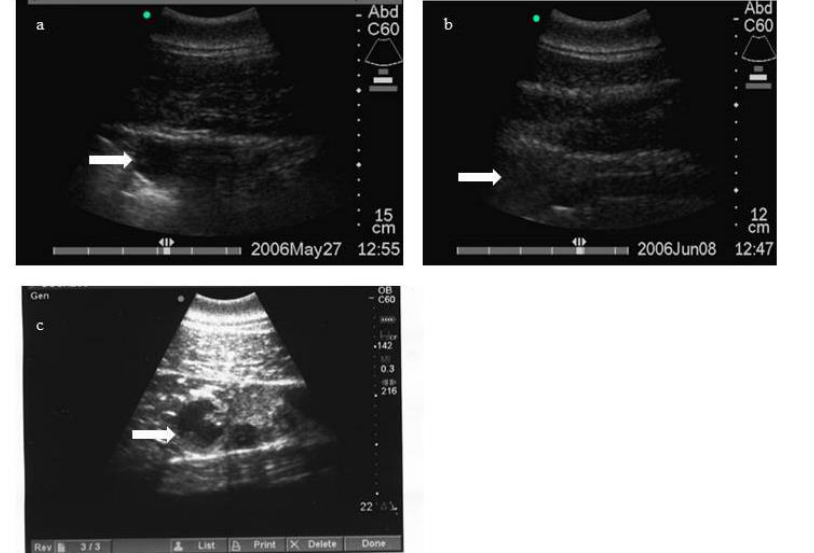
Figure 1. Animal 1 ultrasound. a) white arrow points to pre-ovulatory follicle, b) white arrow points to ovulated follicle, c) white arrow points to uterine fluid and